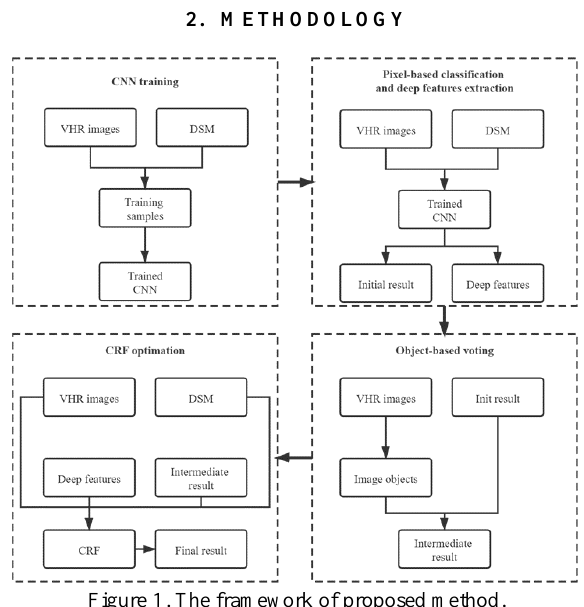
Figure 1. The framework of proposed method.